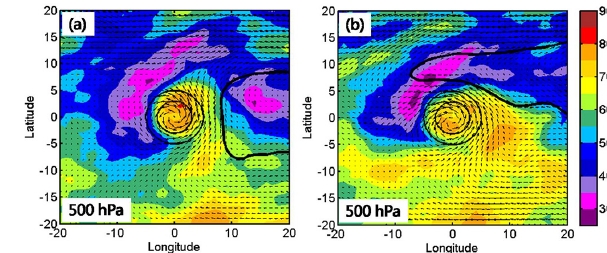
Figure 5. As in Fig. 4 but at 700hPa.